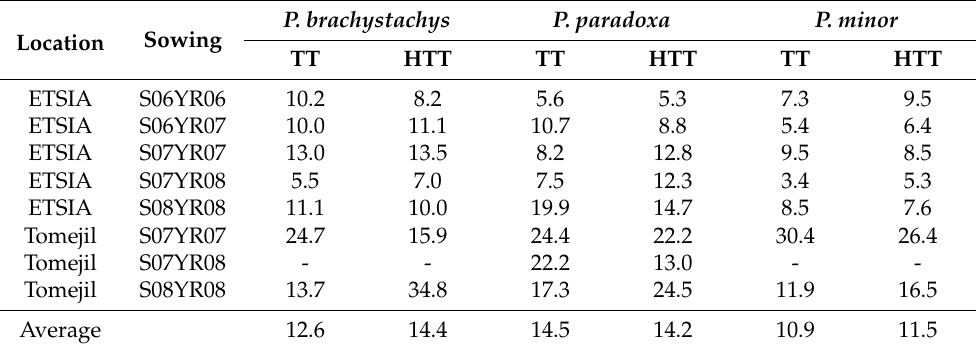
Table 7. Root mean square error (RMSE) values obtained from thermal (TT) and hydrothermal (HTT) time-based Weibull models for each Phalaris